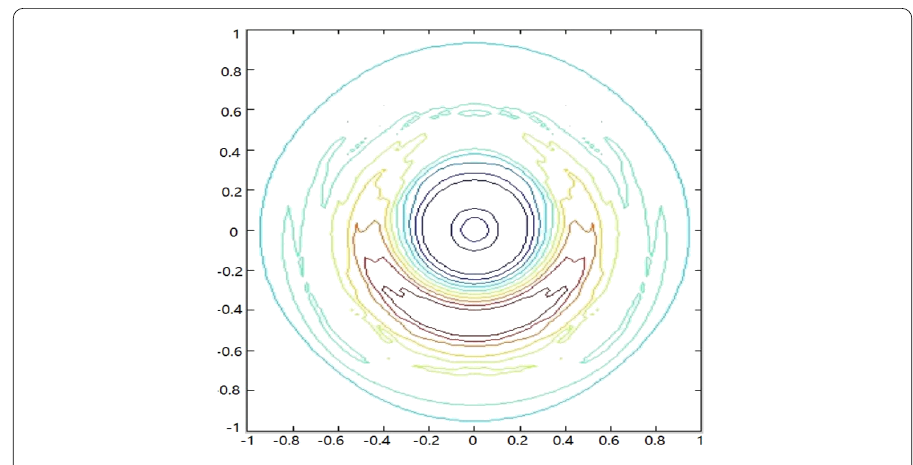
Figure 4 The CCS solution when t = 2.0